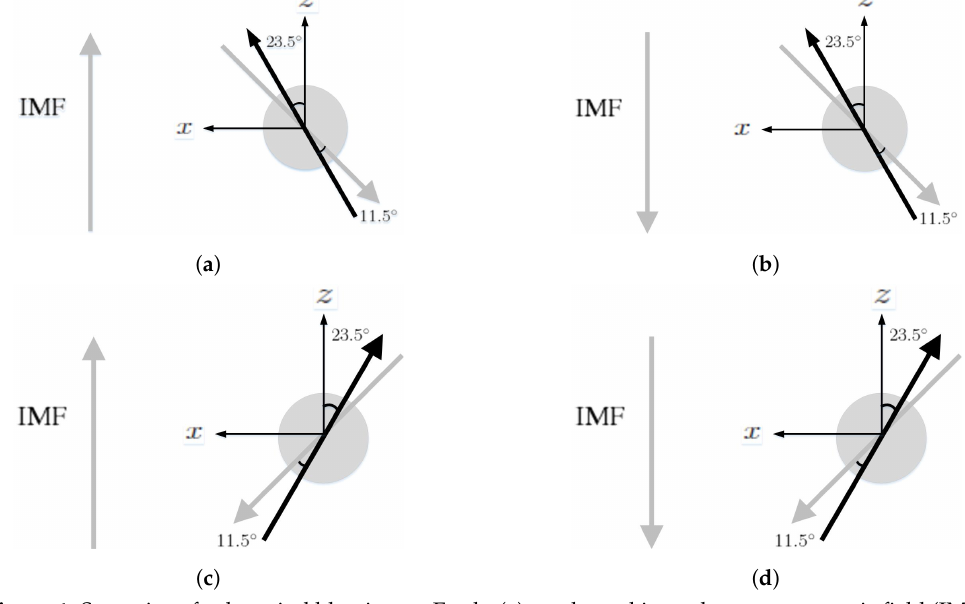
Figure 1. Scenarios of solar-wind blowing on Earth. ( a ) northward interplanetary magnetic field (IMF) in June, ( b ) southward IMF in June, ( c ) northward IMF in December, ( d ) southward IMF in December. The rotational axis (black arrow) tilts by 23.5 ◦ from the orbital normal and the dipole axis (grey arrow) tilts by 11.5 ◦ from the rotational